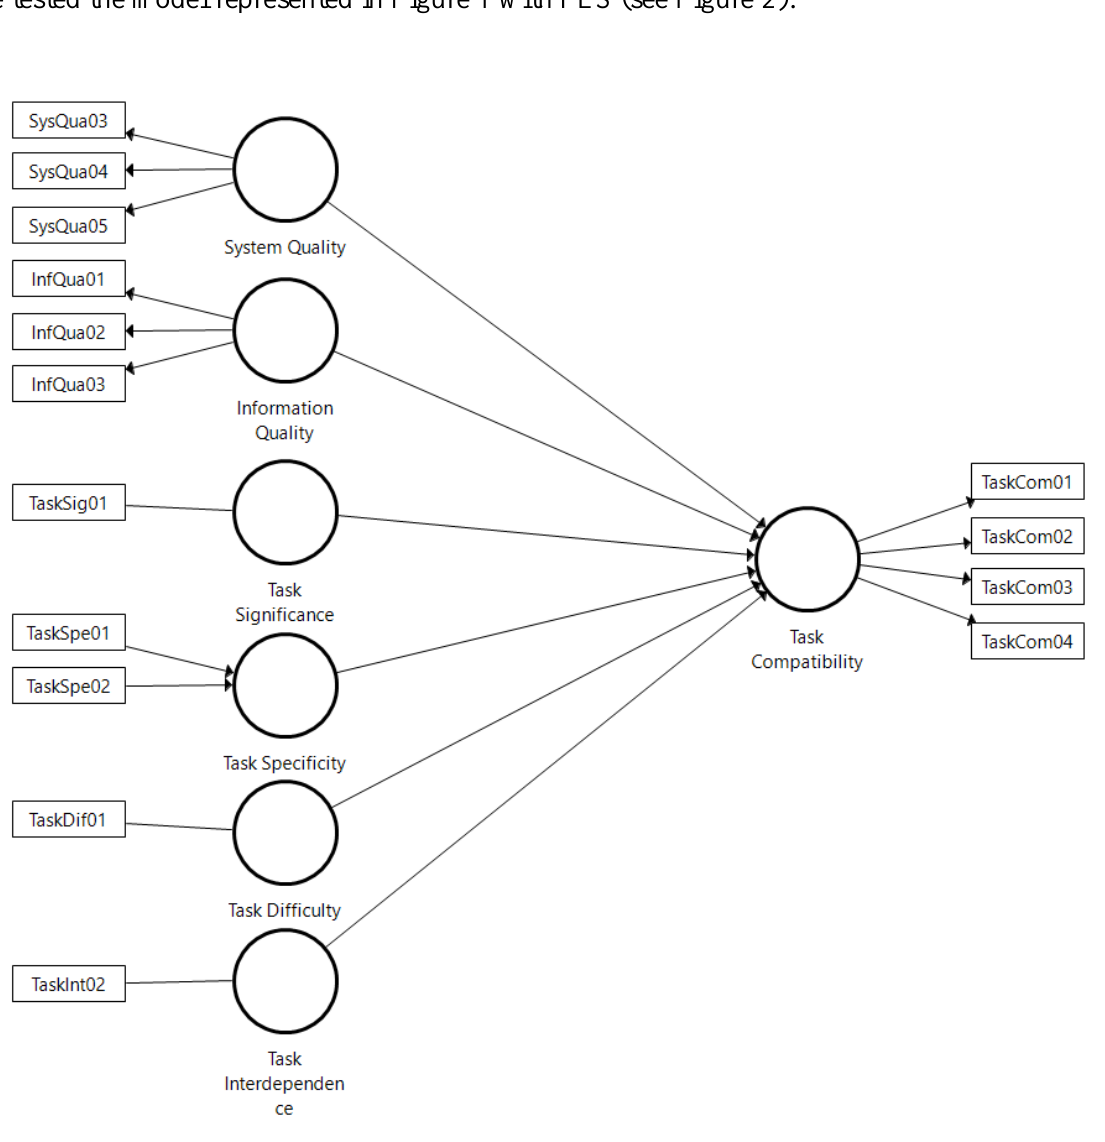
Figure 2 . The tested PLS